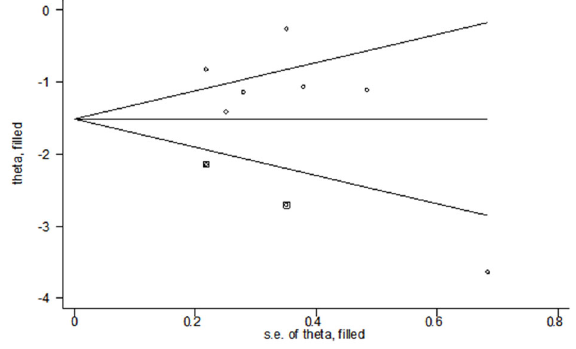
Figure 5. Filled funnel plot of the studies included in the meta- analysis, with pseudo 95% con fi dence signi fi cantly reduced (I 2 =37%), whereas the pooled estimate was not signi fi cantly changed (SMD= – 0.97, P o 0.001,